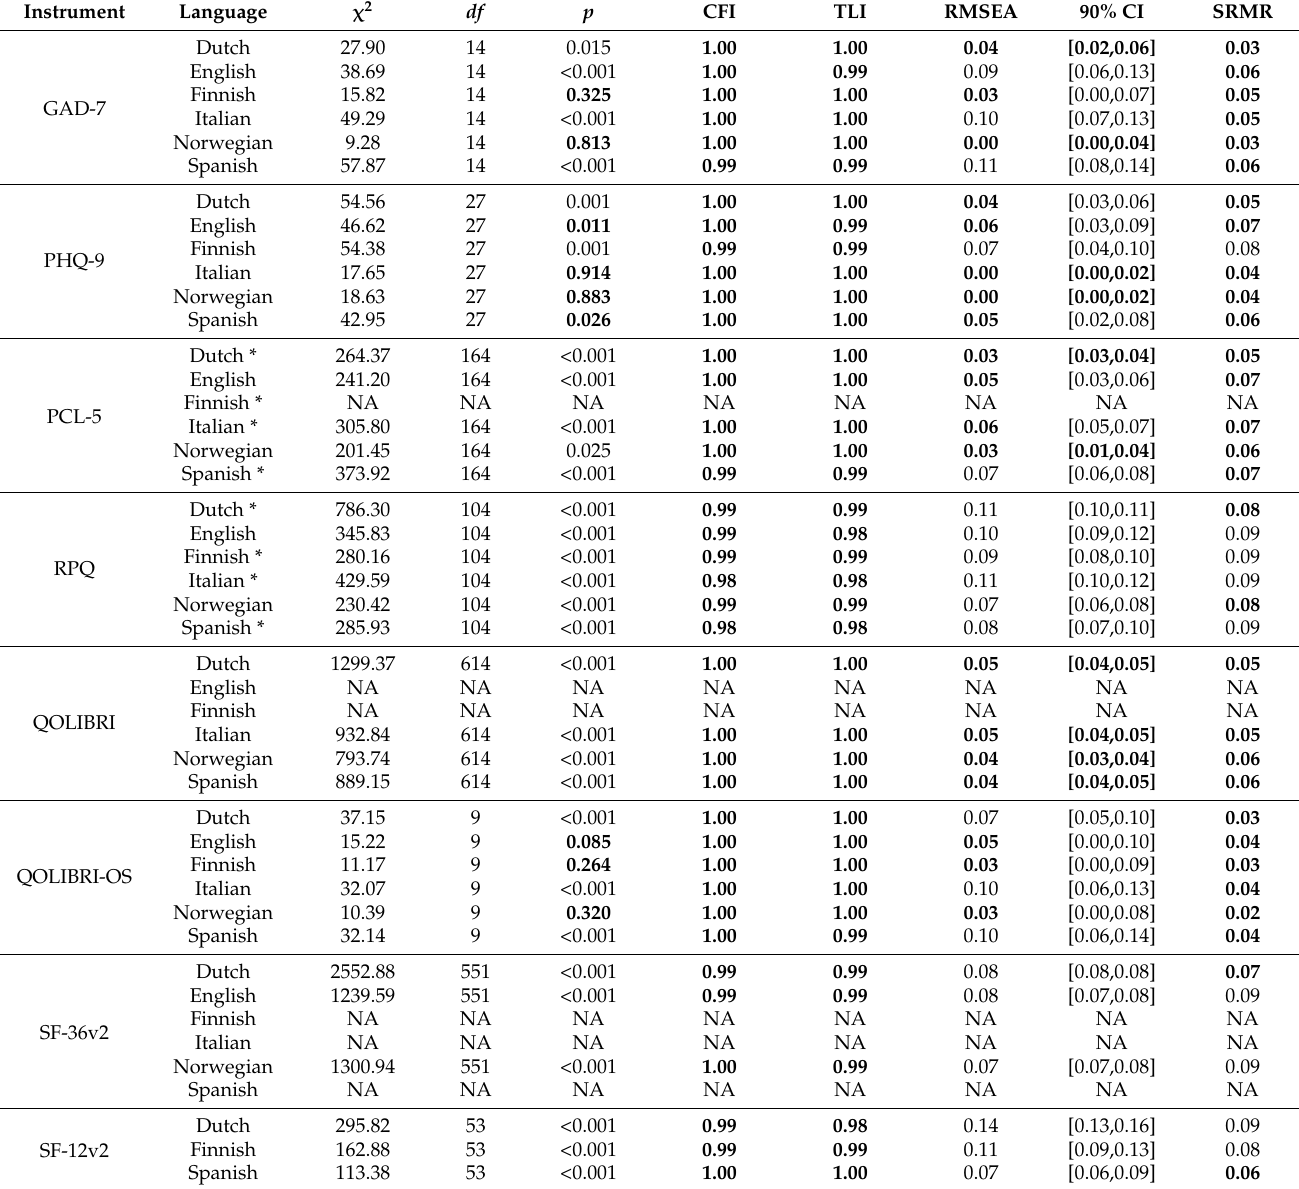
Table 10. Factorial validity: results of the